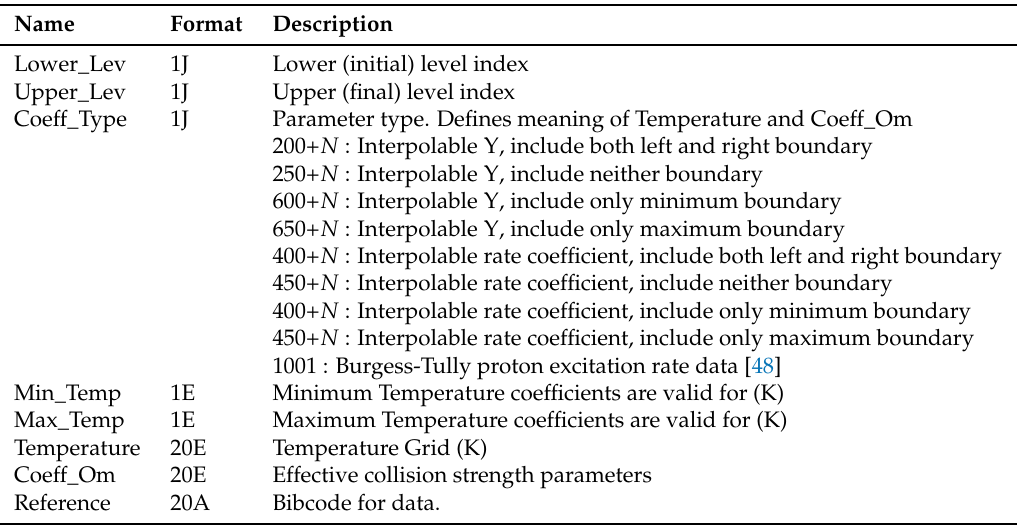
Table A5. APED PC (proton collision) file definition.